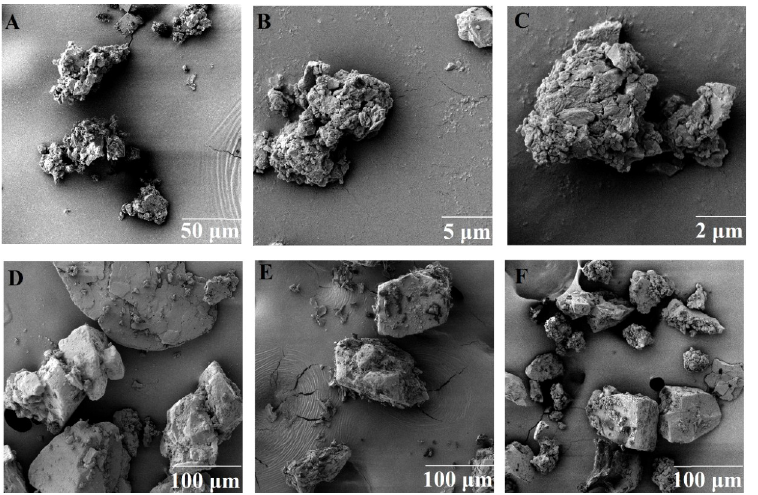
Fig 1. SEM images of puerarin micronized particles at different magnification: (A) Puerarin particles before crushing (original), (B) & (C) Puerarin particles before crushing; and the formulation mixtures (D) Puerarin plus Lactose (F1), (E) Puerarin plus leucine plus Lactose (F2), (F) Puerarin plus magnesium stearate plus Lactose